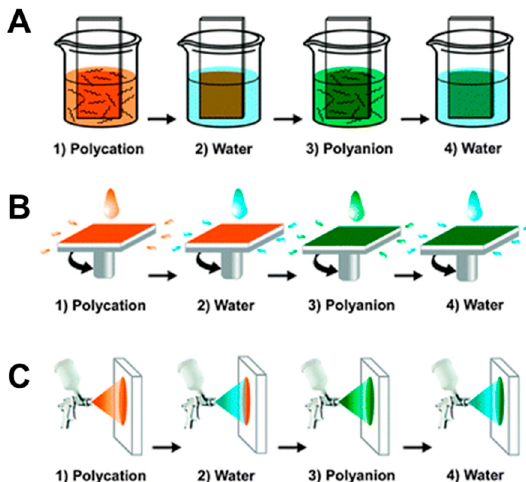
Figure 2. Schematic representation of the processes used to fabricate polyelectrolyte multilayer films by layer-by-layer (LbL) assembly. ( A ) Dip coating: glass slides and beakers are used in this method. Steps (1) and (3) represent the exposure of a polyanion and polycation, respectively, and steps (2) and (4) are rinsing steps. The four steps are in the basic build-up sequence and contribute to only one-bilayer film architecture. If the 10-bilayer film is needed, the four procedures would be repeated 10 times. Construction of more complex film requires additional beakers and an extended deposition sequence. ( B ) Spin-assisted LbL assembly: High spinning speed would be operated after the droplet of the material is applied onto the center of the substrate surface. The rinsing step would take place between steps (1) and (3), and all the four steps are in a circulation system. ( C ) Spray-assisted LbL assembly: Instead of bringing the substrates’ surface into contact with the liquid of the adsorbing